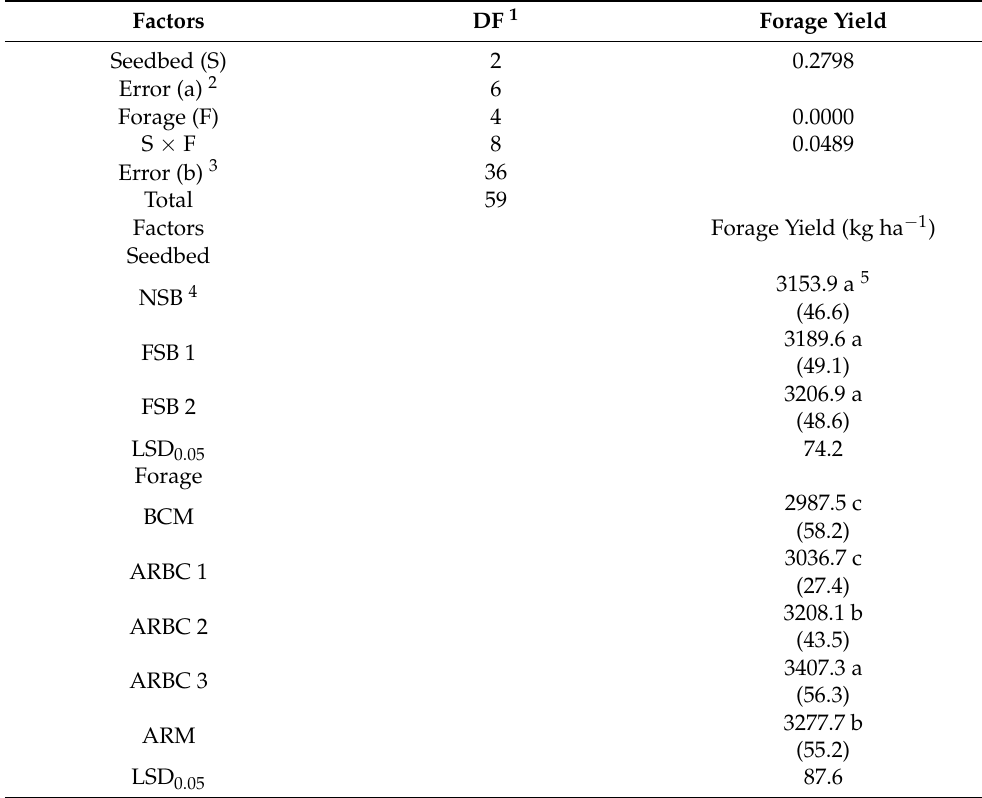
Table 6. The effects of seedbed (S) and forage (F) on forage yield in the second harvest. Data were pooled over 2020–2021 and 2021–2022. Forage yield data (kg ha − 1 ), pooled over 2020–2021 and 2021–2022 are also